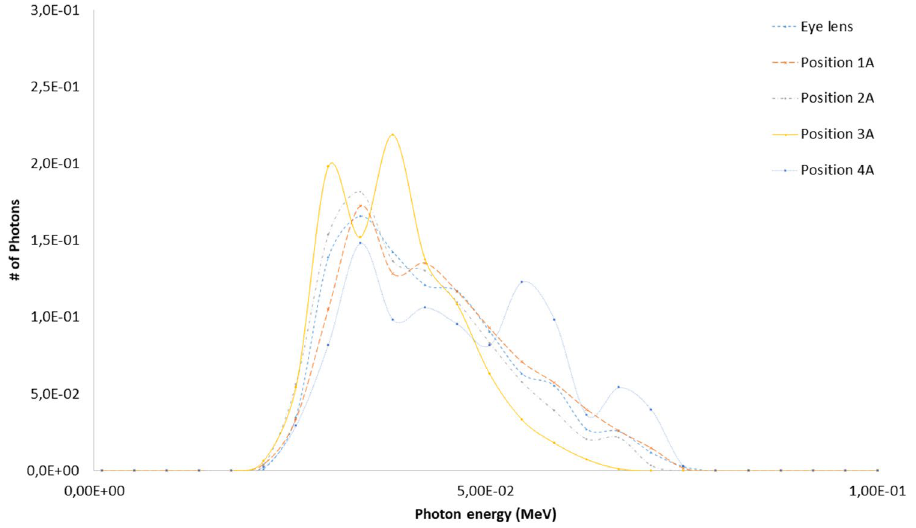
Figure 7. Scenario A. Photon spectra at the detectors (see Fig. 2 for details of position and characteristics) estimated with the MCNP code with the 80 kV endpoint X-ray source. Photon energy scale in